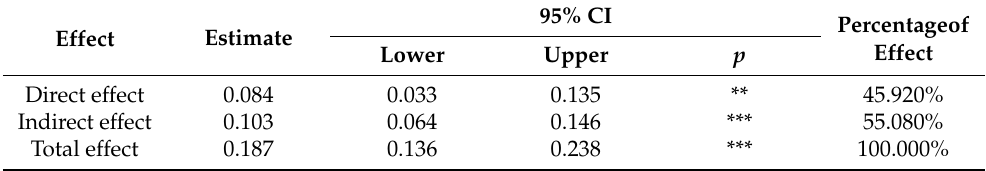
Table 3. Mediating effects and 95% confidence intervals estimated by the bootstrap method.